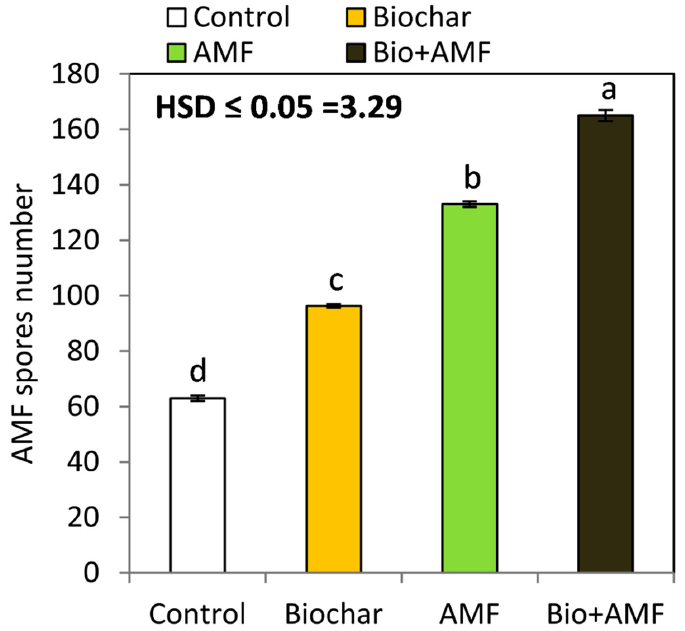
Figure 3. Impact of biochar and AMF on the AMF spores in soil. Data are means of five replicates ( n = 5), and for each parameter, the mean values ± SD followed by a different letter are significantly different according to Tukey’s HSD range test at p ≤ 0.05.